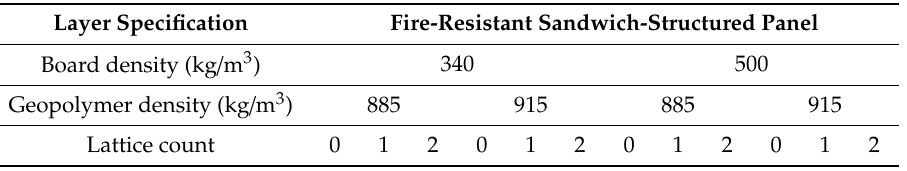
Table 4. Geopolymer